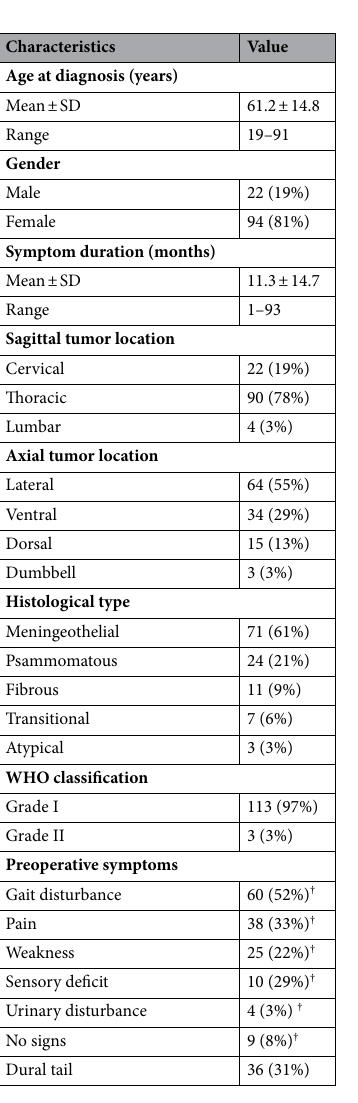
Table 1. Summary of patient characteristics (n = 116). † Overlap in some